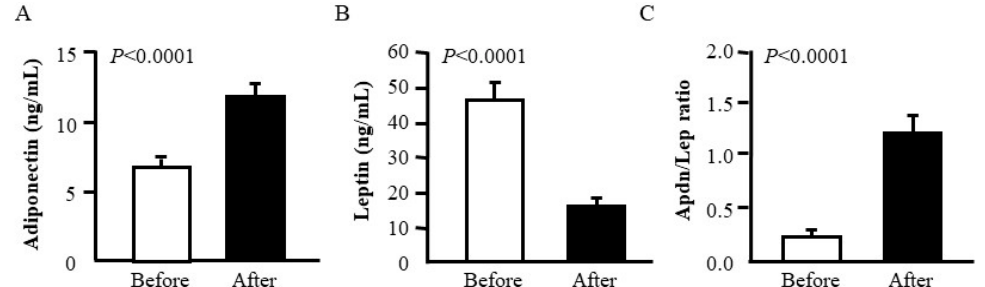
Figure 1. Comparison of serum adiponectin ( A ) and leptin ( B ) concentrations as well as the Adiponectin/Leptin (Adpn/Lep) ratio ( C ) before and after Roux-en Y gastric bypass in patients with